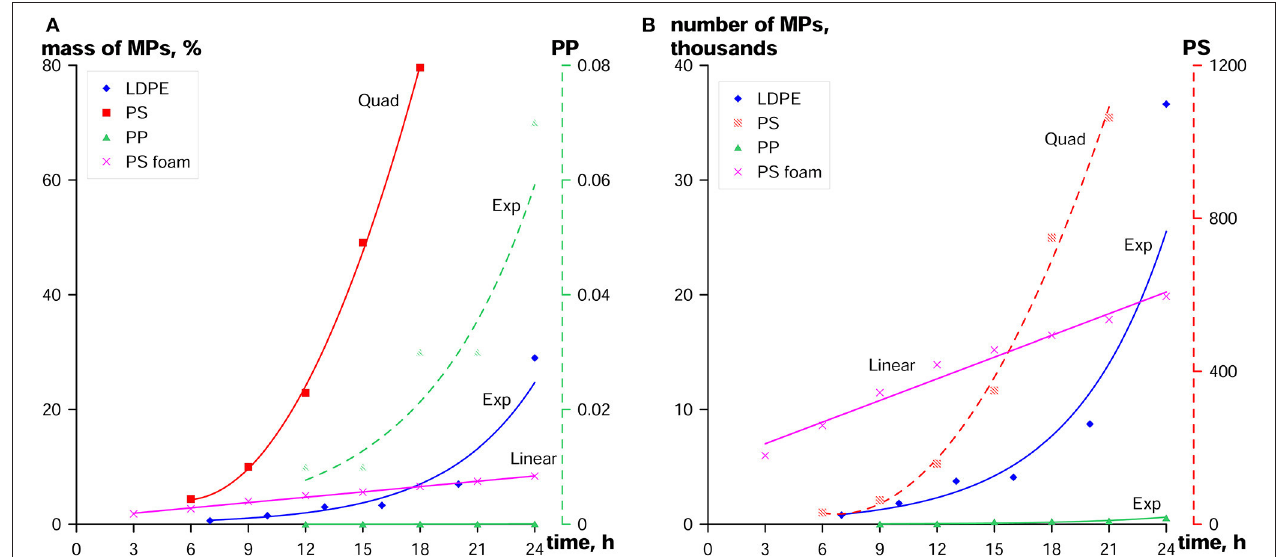
FIGURE 5 | Increase in (A) mass (in per cent of the total mass of the given plastic) and (B) number of MPs particles with time of the experiment for four types of plastic materials. Initial mass of LPIs of LDPE, PS, and PP was 200g, of PS-foam–50g. Additional axes at the right-hand side, the dashed graphs, and pale markers show: (A) enlarged exponential best fit for the mass of PP MPs; data and graph at the same scale with other plastics are shown by green triangular markers/solid line; (B) best fit for the number of solid PS MPs at much compressed scale.